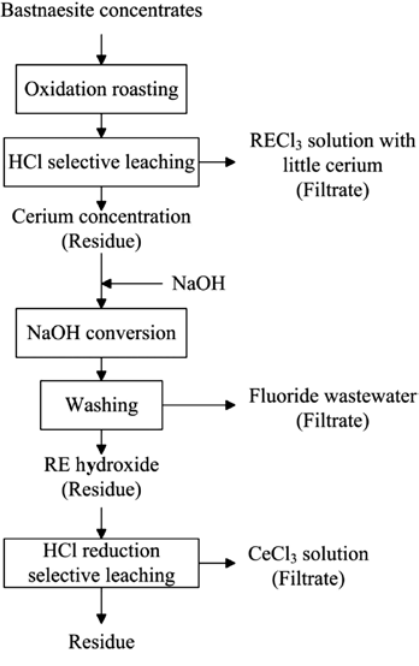
Figure 1: The flow sheet of process involves oxidation roasting, hydrochloric acid leaching and caustic